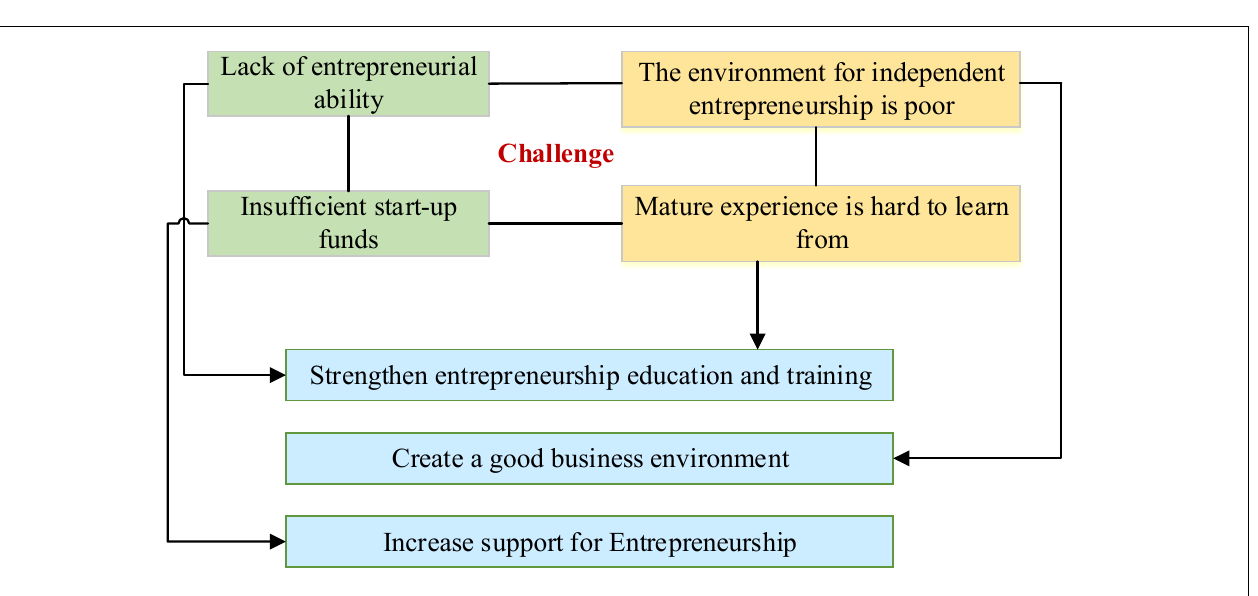
Frontiers in Psychology |